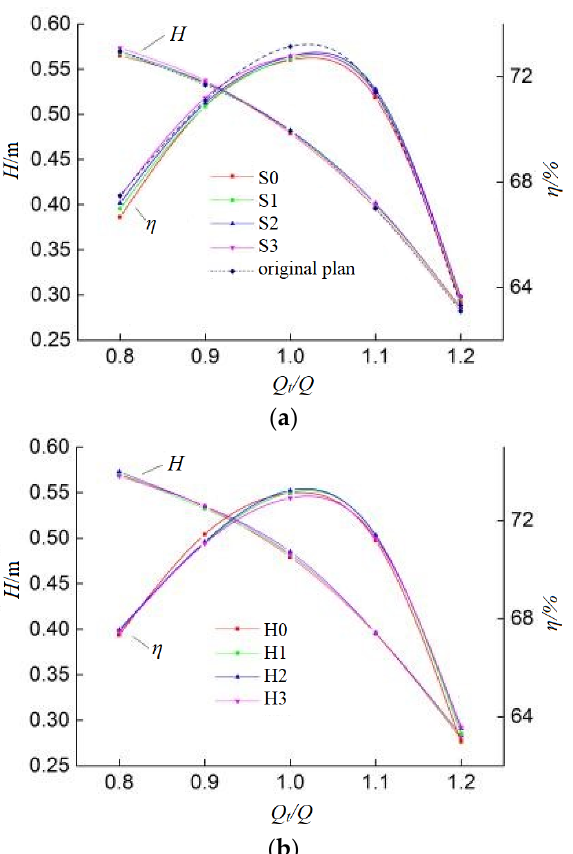
Figure 5. Comparison of numerical simulation and experimental results.